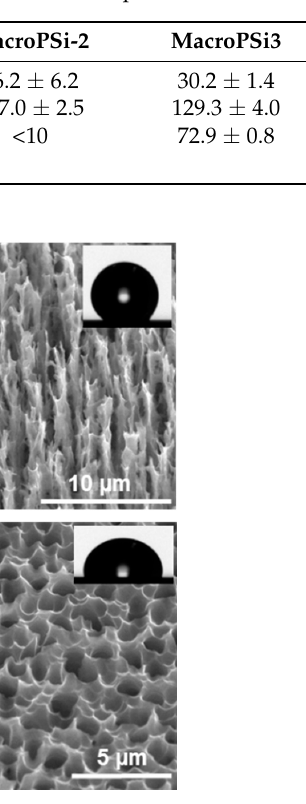
Figure 3. ESEM images of the studied macroporous silicon substrates: ( a ) MacroPSi-1; ( b ) MacroPSi-2; ( c ) MacroPSi-3; ( d )